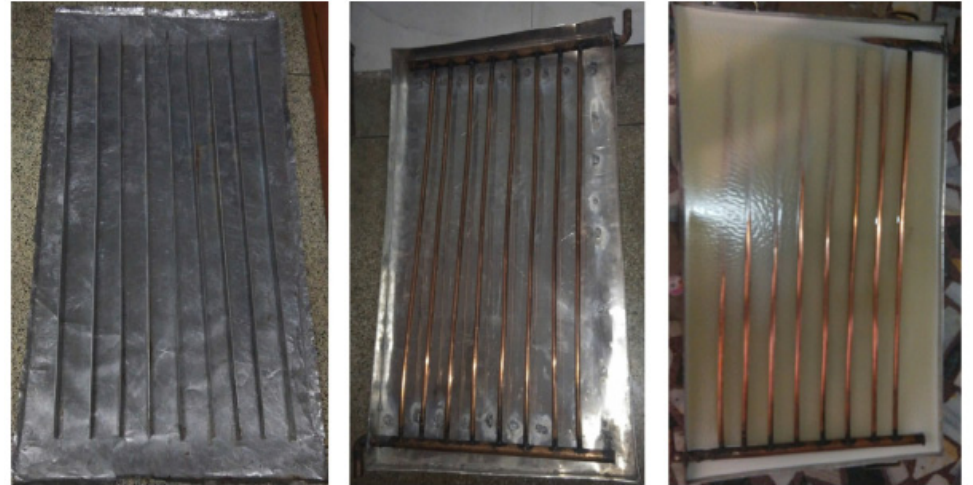
Figure 10. Diagram of three types of absorber plate used by Zhou et al.